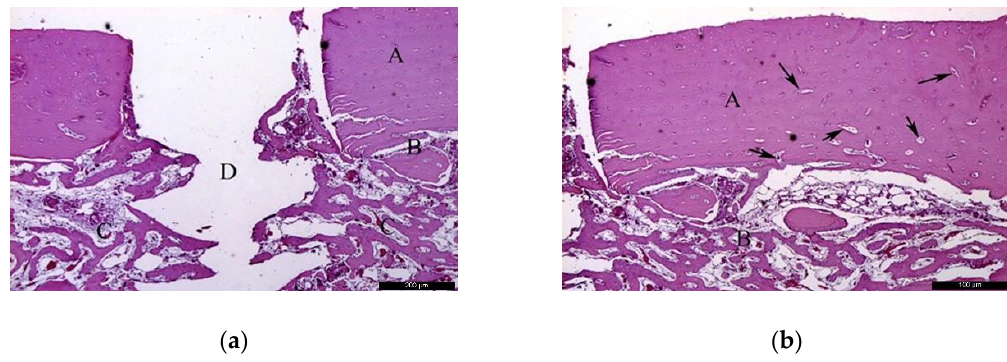
Figure 3. Histological analysis of the autogenous group (AG) at 30 days. ( a ) Autogenous bone graft (A) positioned over the recipient bed (B), trabeculae in maturation stage and good vascularization (C); space previously occupied by the osteosynthesis screw is recognizable in (D). Hematoxylin and eosin stain at a magnification 40×; ( b ) Autogenous bone (A) newly formed bone (B), and small areas of resorption (black arrows). Hematoxylin and eosin stain at a magnification 125×.